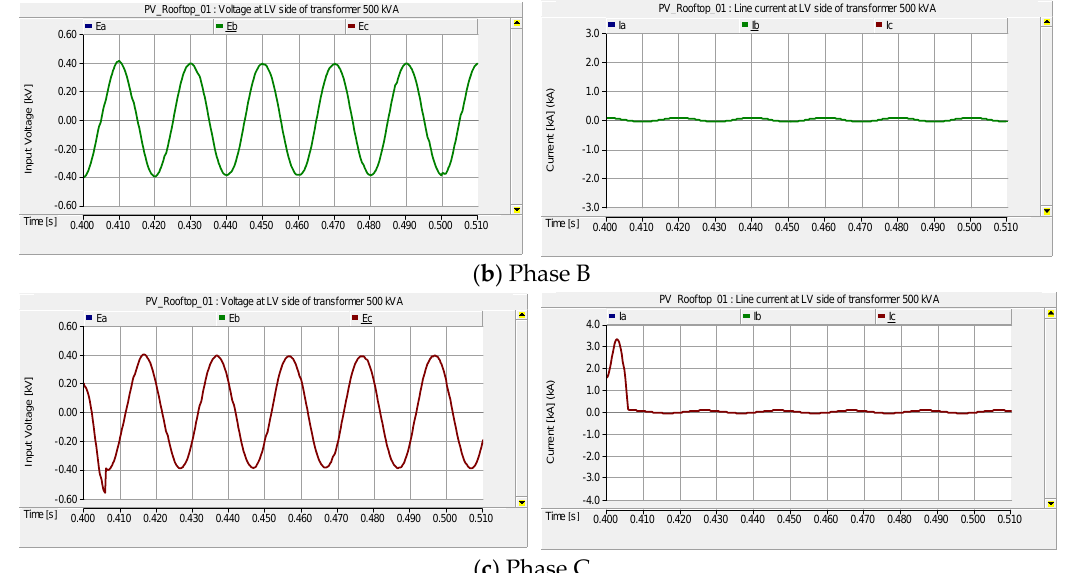
Figure 19. The voltage and current at the LV side (0.4 kV) transformer 500 kVA when the BRKC open circuit is at 0.4 s.